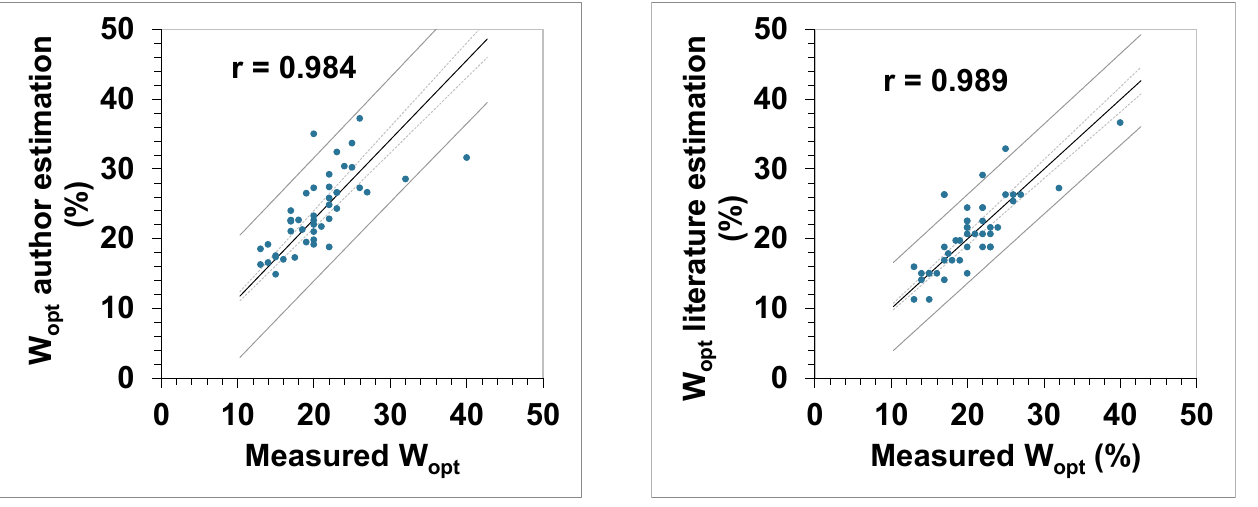
Figure 6. Correlation between measured data from [30] and estimated w Opt using the literature estimation [30] and author equations.